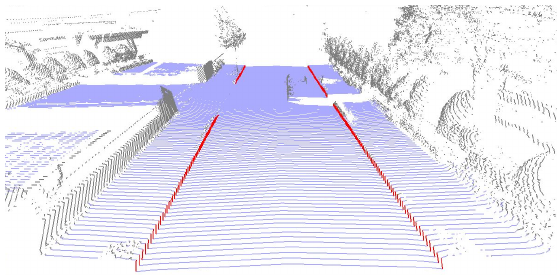
Figure 14: Discrimination of the curb and the ground